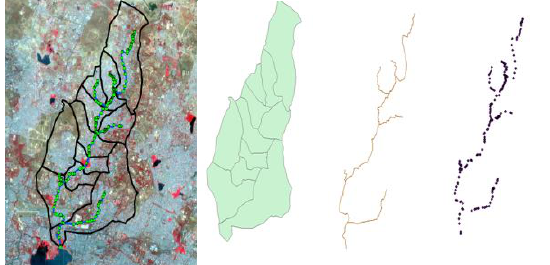
Figure 4: Georeferenced Auto CAD drawing (left) and shape files of Sub catchments, Drain network and junctions (right) Table 1: Details of sub-catchment